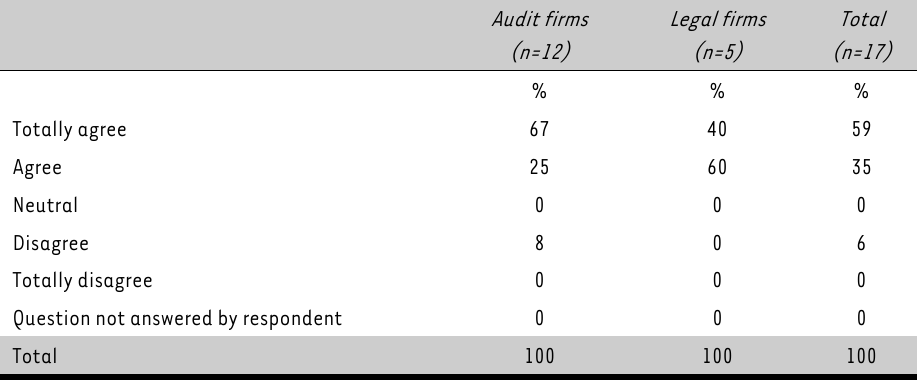
TABLE 9: Results of Question 4.4.7